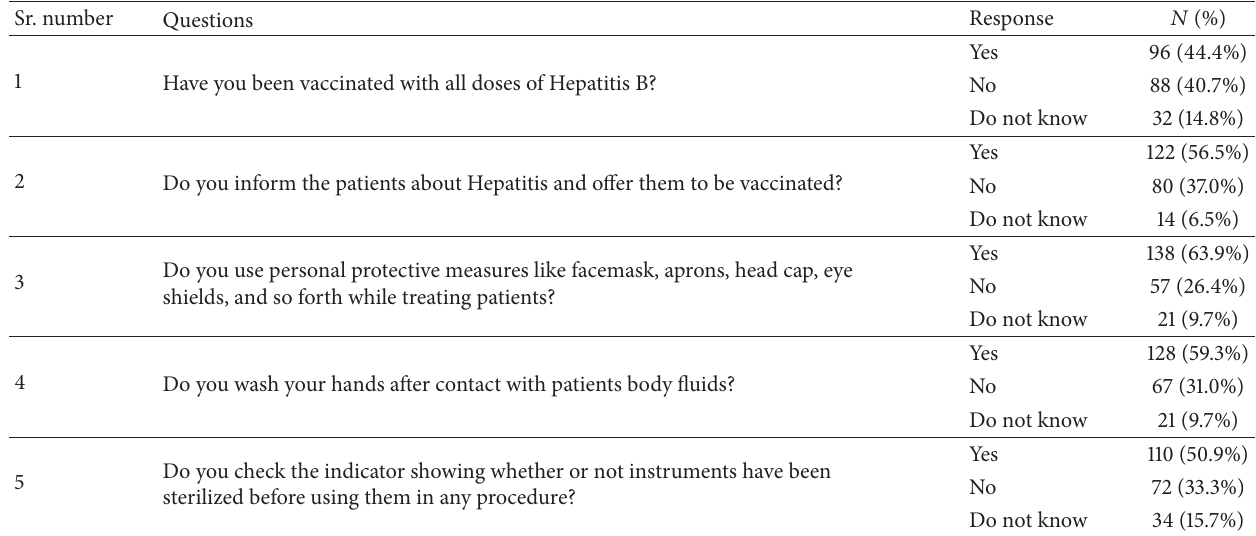
Table 3: Preventive practices of students regarding Hepatitis B.